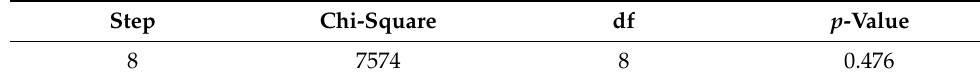
Table 4. Hosmer and Lemeshow